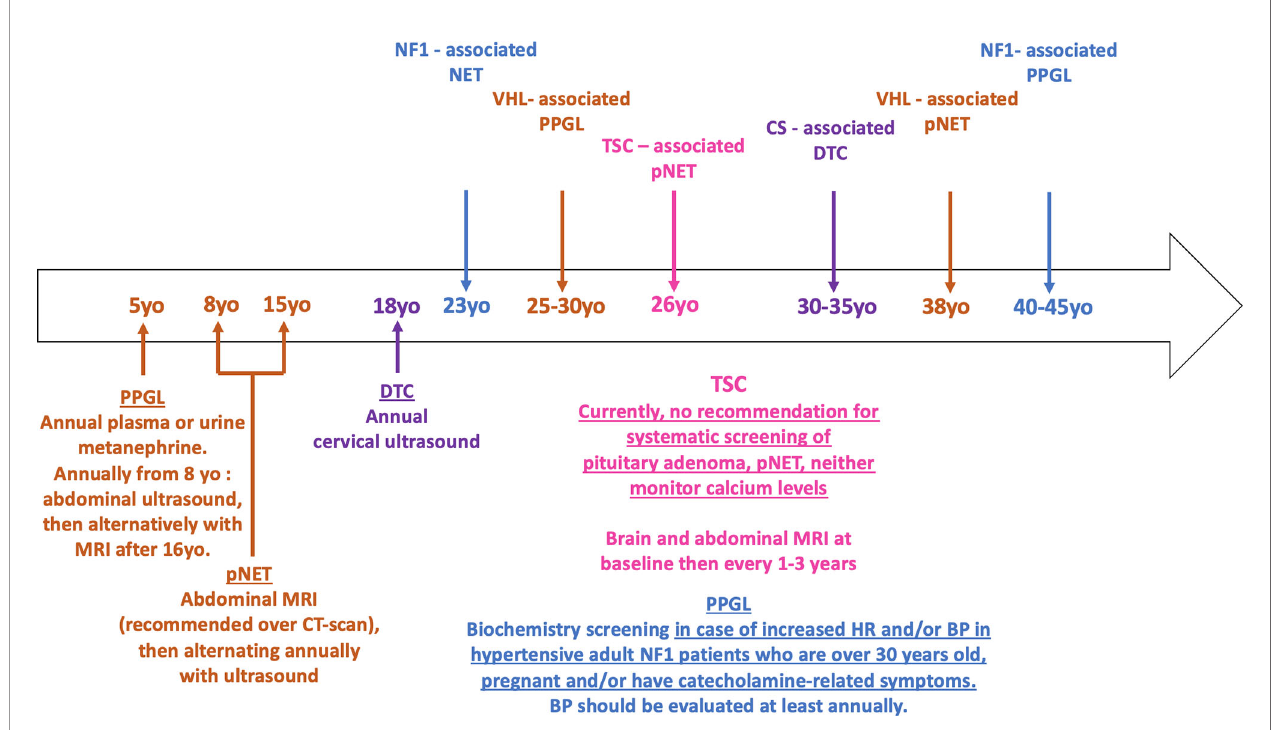
FIGURE 4 | Timeline of phakomatoses-associated endocrine tumors and follow up strategy. The median age of onset of phakomatoses-associated endocrine tumors is shown in the arrow. The various follow up guidelines according to the syndromic presentation are shown below the arrow. Brown = VHL; purple = CS; fuchsia = TSC; blue = NF1. HR, heart rate; BP, blood pressure; pNET, pancreatic neuroendocrine tumor; PPGL, pheochromocytoma/paraganglioma; DTC, differentiated thyroid